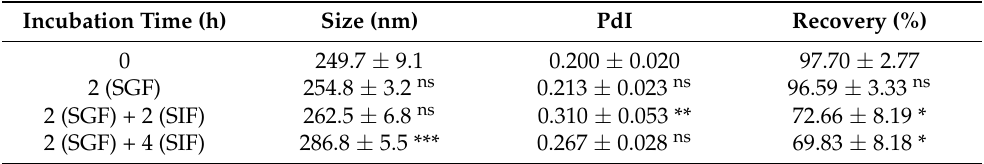
Table 3. Physical and chemical stability of K-NLCs, in terms of size, PdI, and recovery of khellin, re- spectively, in simulated gastric fluid (SGF) and simulated intestinal fluid (SIF) for different incubation times. Data are shown as the mean ± standard deviation ( n = 6).